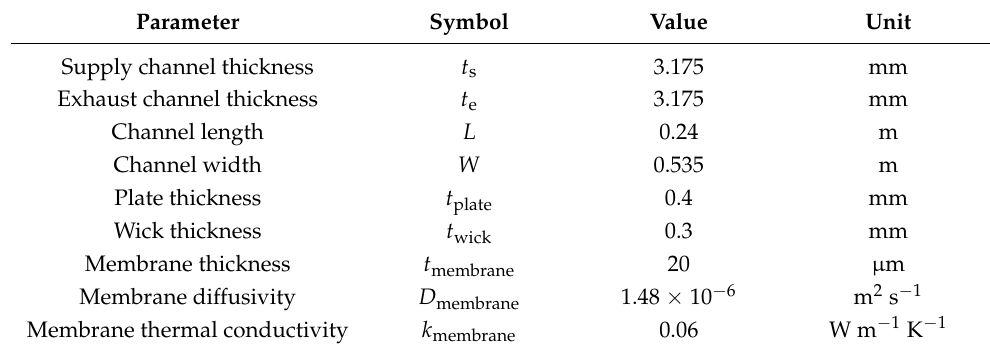
Table 1. Specifications of the